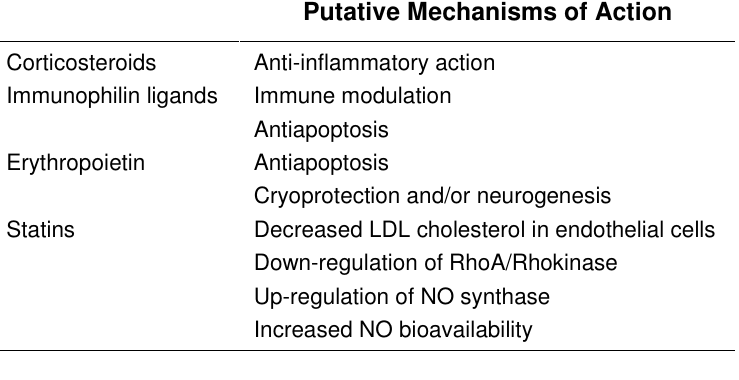
Medical Therapies for Improving Erection Recovery Putative Mechanisms of Action